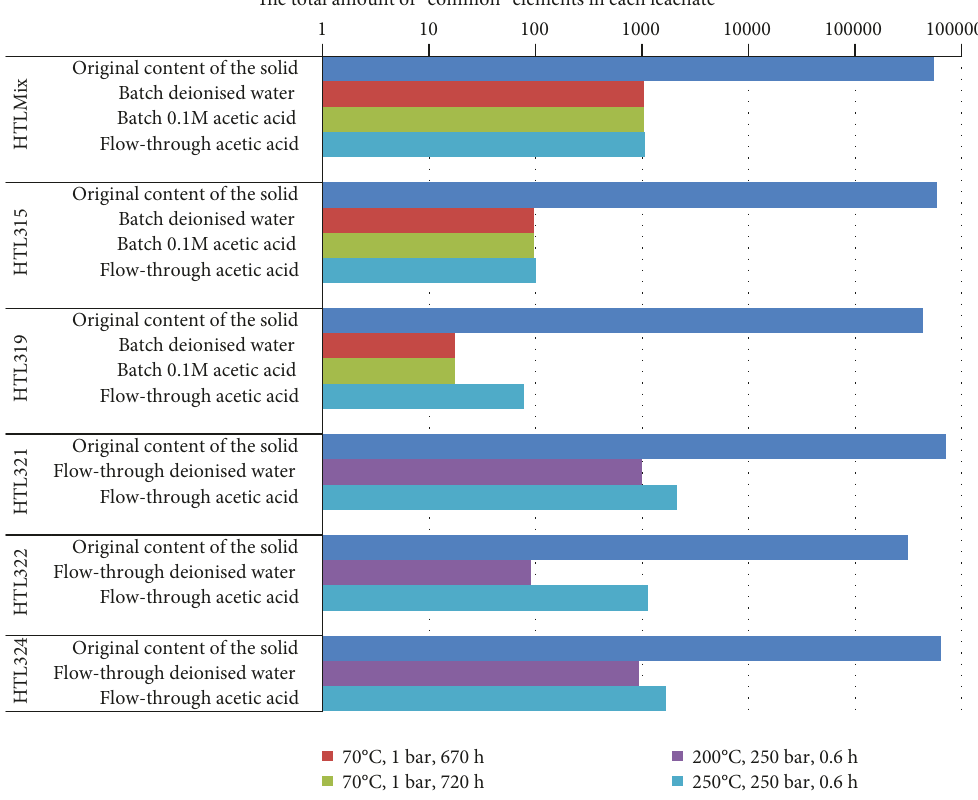
Figure 22: Summarising chart of detected “ common ” elements during each experiment with concentrations in